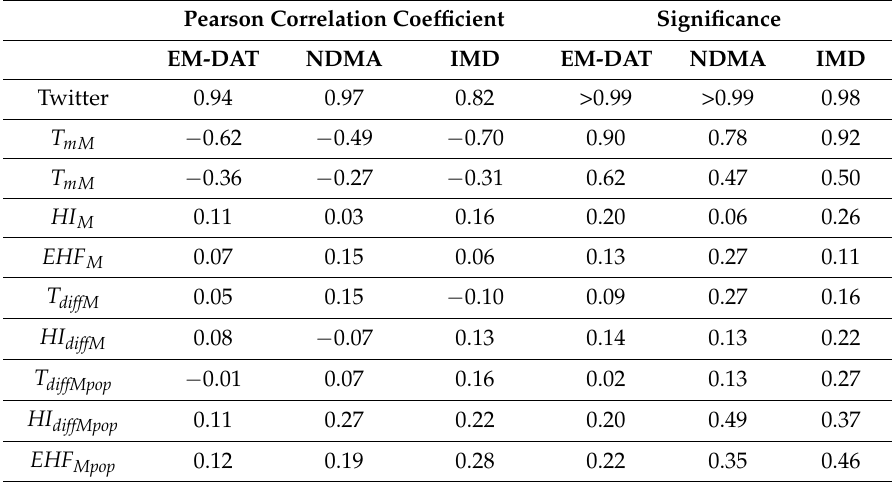
Table 4. Pearson correlation coefficient between mortality data according to the three available mortality databases and the Twitter and heat wave indicators, together with their significance (1 − p ).